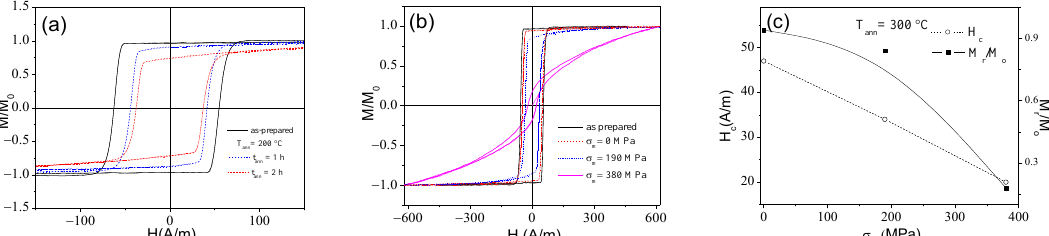
Figure 18. Hysteresis loops of as-prepared and stress-annealed at T ann = 200 °C, σ ≈ 900 MPa for different t ann ( a ), effect of tensile stress applied during the annealing at T ann = 300 °C on hysteresis loops ( b ) and H c and M r /M o values ( c ) of Fe 75 B 9 Si 12 C 4 microwires. Figure 18a is adapted from [87] Figure 2 (Copyright © 2018, Springer Nature, Open Access).